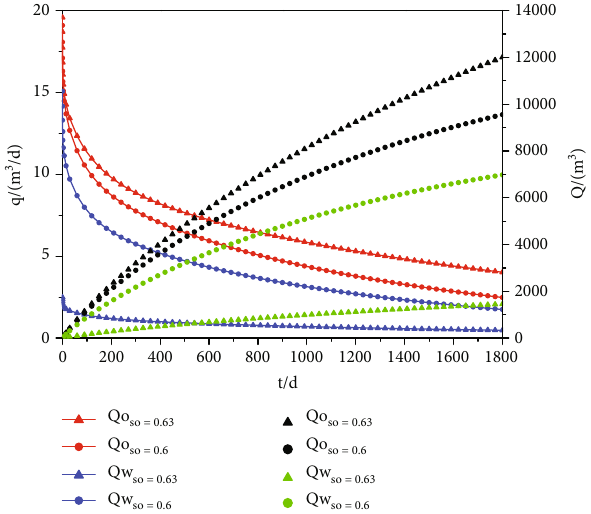
Figure 5: Daily production and accumulative production under di ff erent water